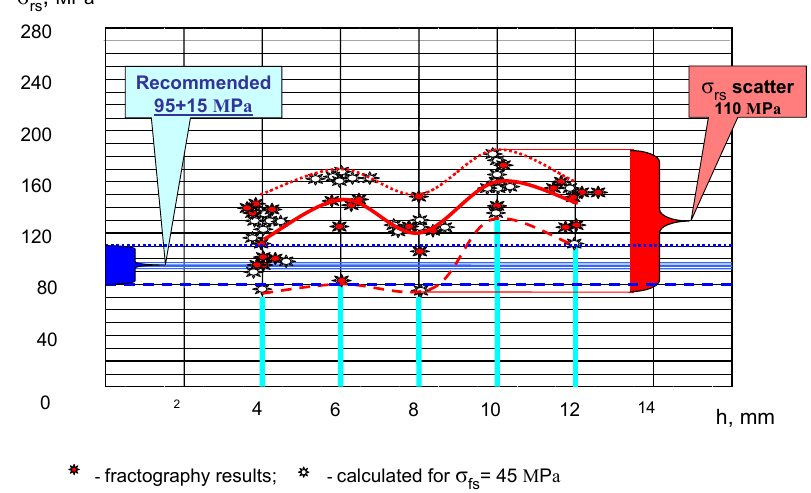
Figure 9 Residual compressive stress and quality of the hardened